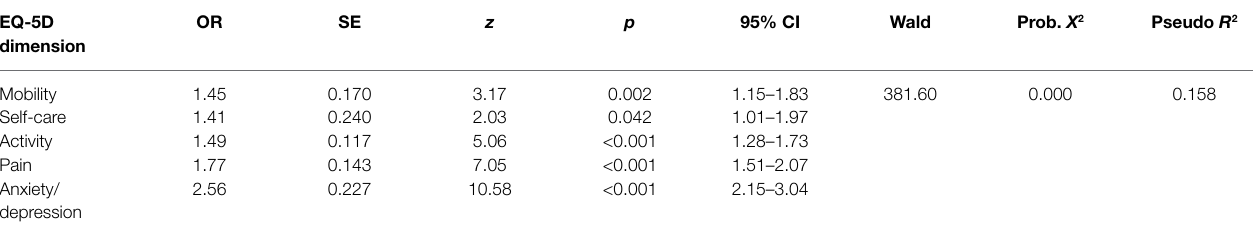
TABLE 5 | Ordinal logistic regression predicting severity of depression and anxiety symptoms ( N = 890). EQ-5D